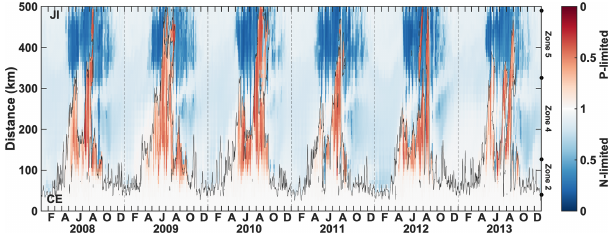
Figure 5. Time series of the nutrient limitation factor along the CE– JI transect (see Fig. 1). The color represents the most limiting nu- trient at each time and location, either N (blue) or P (red). The thin black line indicates the location of the 29 isohaline. The dots on the right y axis indicate the limits of zones 2, 4, and 5.